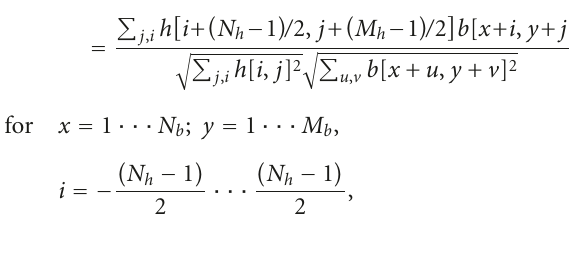
algorithm (CCA) (5) and the normalized cross-correlation algorithm (NCCA) (10) [34], are compared to three